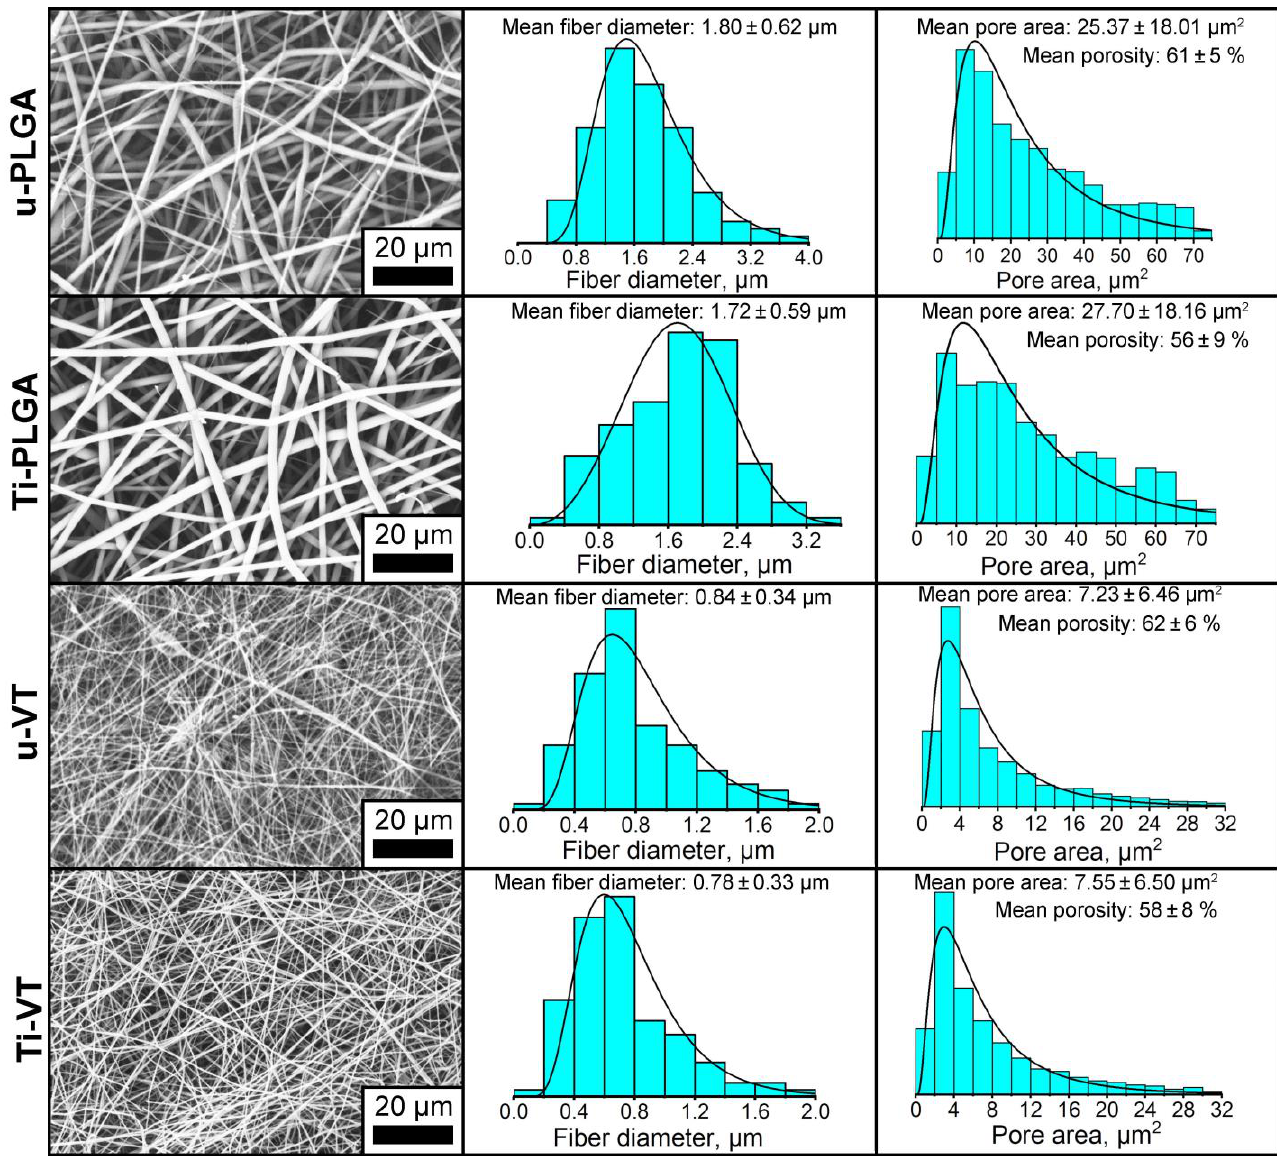
Figure 2. Scanning electron microscope (SEM) micrographs on the left side, histograms of scaffold fiber diameter in the middle and histograms of the scaffold pore area on the right side of u-PLGA, u-VDF-TeFE, Ti-PLGA and Ti-VDF-TeFE scaffolds.